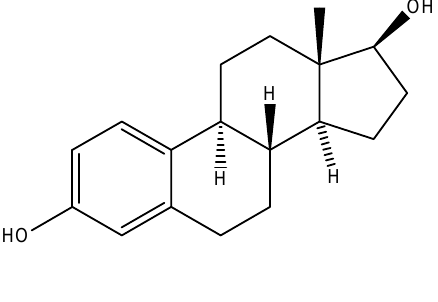
Figure 8. Chemical structure of 17- β